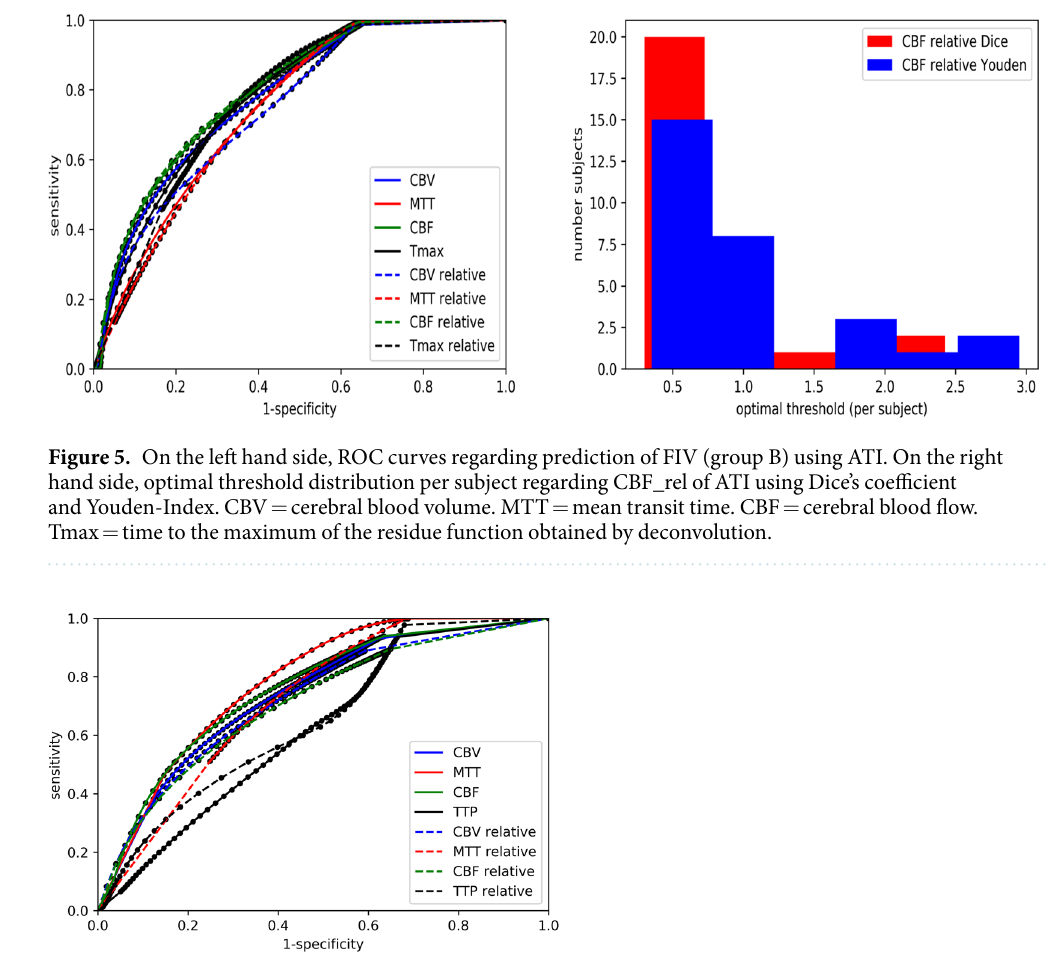
Figure 6. ROC curves regarding prediction of FIV (group B) using ATS. CBV = cerebral blood volume. MTT = mean transit time. CBF = cerebral blood flow. TTP = time to